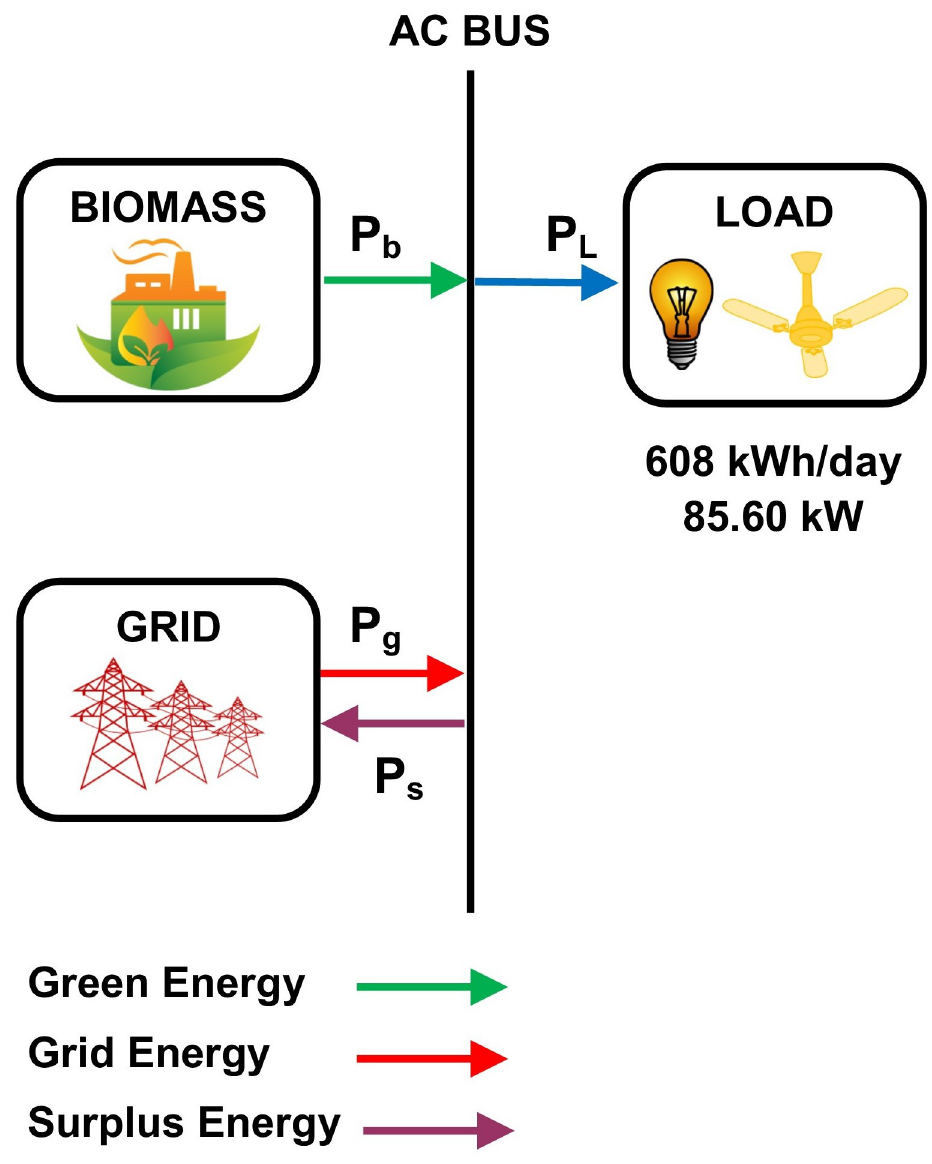
Fig 5. The hybrid energy model-B for the prosumer community.